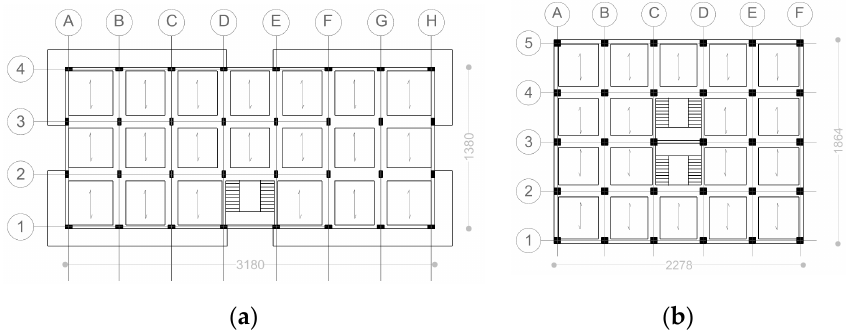
Figure 4. Plan archetypes: ( a ) Type 1 low- or mid-rise and ( b ) Plan B mid- or high-rise buildings.